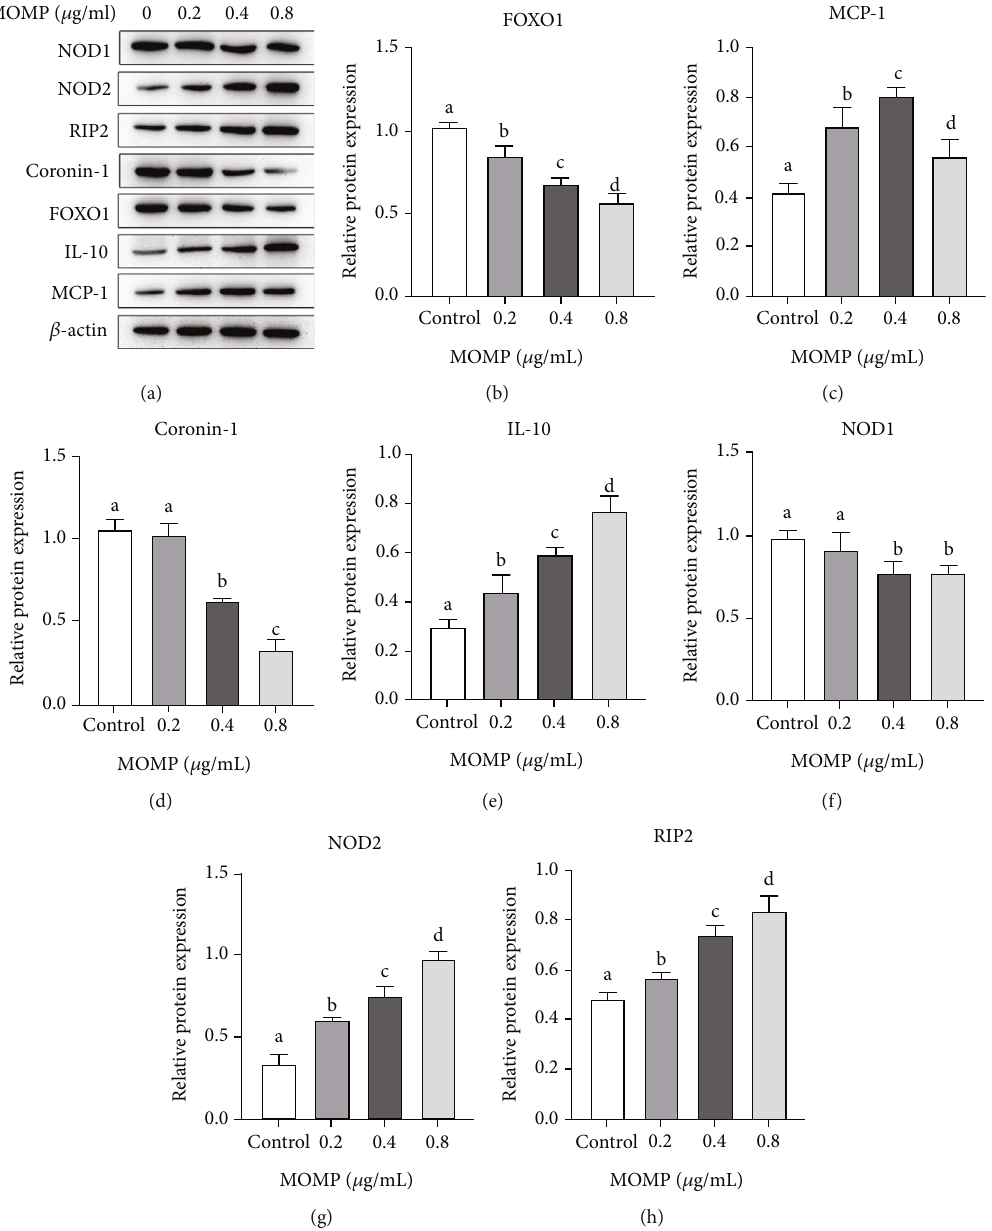
Figure 4: Expression analysis of 7 proteins at the protein level in RAW 264.7 treated by MOMP for 24 h. The signi fi cant di ff erences in the expression of 7 proteins in groups treated with di ff erent concentrations were marked by the alphabetic notation (a, b, c, and d). In each detected expression of 7 proteins, if any two histograms with the same marking letter represented no signi fi cant di ff erence between two concentration treatments, any two histograms without the same marking letter represented a signi fi cant di ff erence. Relative protein expression analysis in each group was performed on the basis of the gray value of internal control β -actin. (a) Western blotting analysis of 7 proteins and β -actin. (b – h) Relative protein expression of FOXO1, MCP-1, coronin-1, IL-10, NOD1, NOD2, and RIP2 for 24 h treated by di ff erent concentrations of MOMP. Control represented the cells cultured in the normal medium; 0.2 represented the cells cultured in the medium containing 0.2 μ g/ml MOMP; 0.4 represented the cells cultured in the medium containing 0.4 μ g/ml MOMP; 0.8 represented the cells cultured in the medium containing 0.8 μ g/ml MOMP (error bars = SD